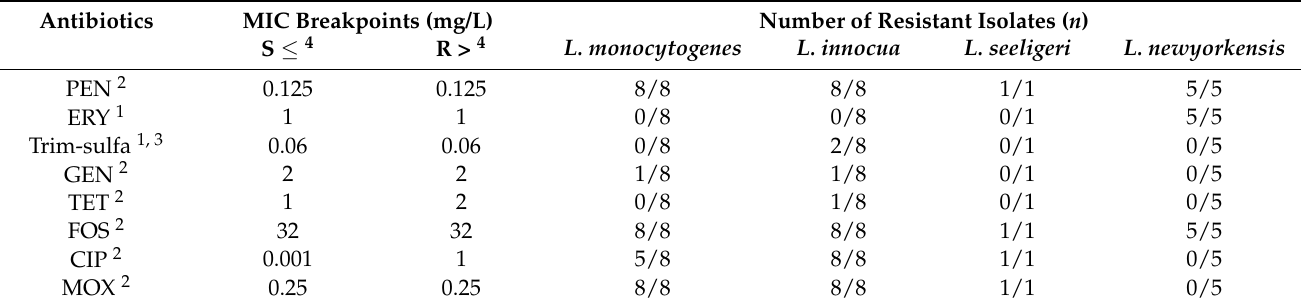
Table 3. Phenotypical characterization of 22 Listeria isolates.